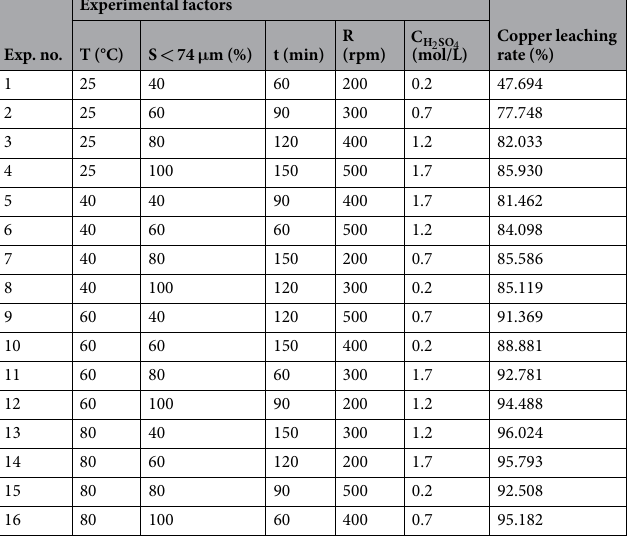
Table 3. L 16 (4 5 ) experimental table of copper leaching